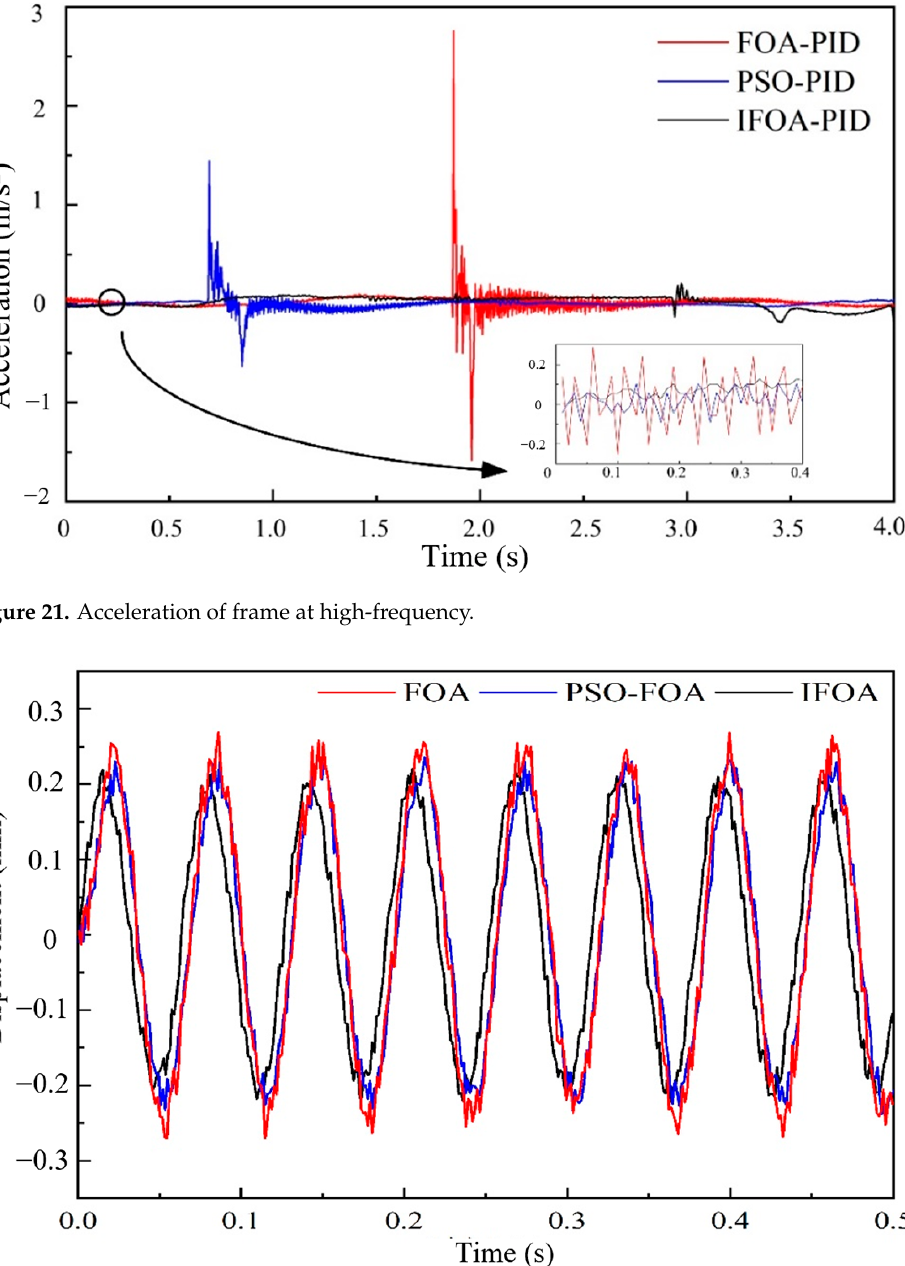
Figure 20. Displacement of frame t at low frequencies.